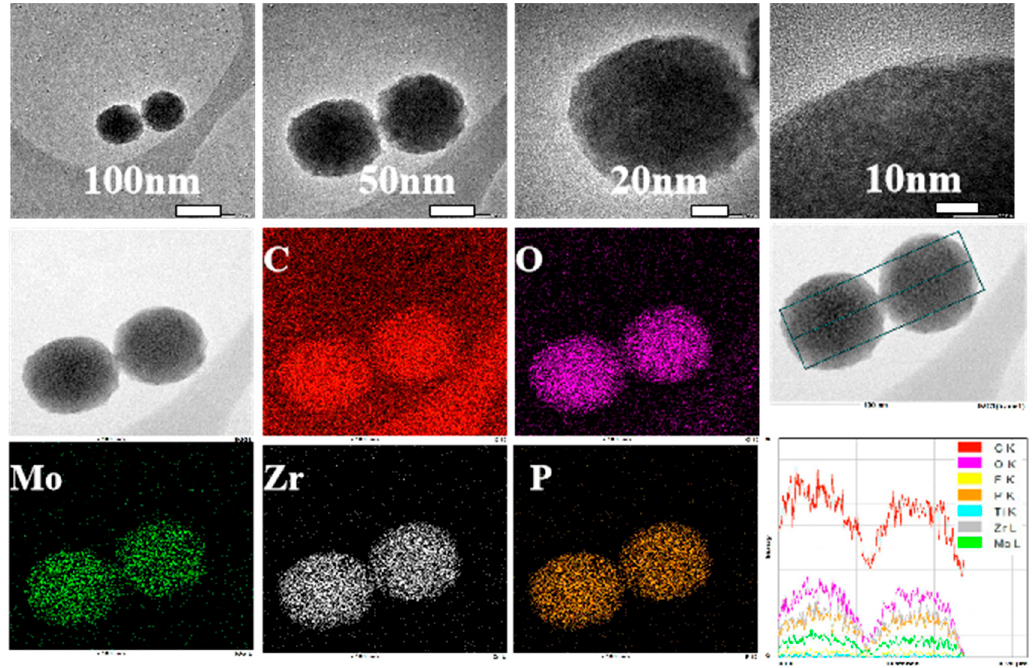
Figure 2. TEM element mapping images and TEM-EDS results of TiF 4 -PU-200.